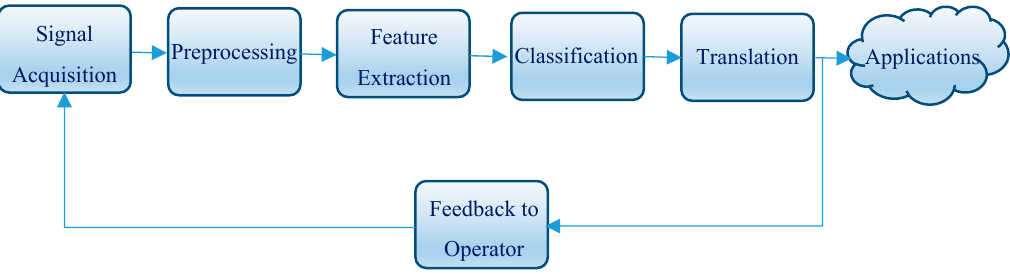
Figure 1. Block diagram representing the processes performed in a typical Brain–Computer Interface.